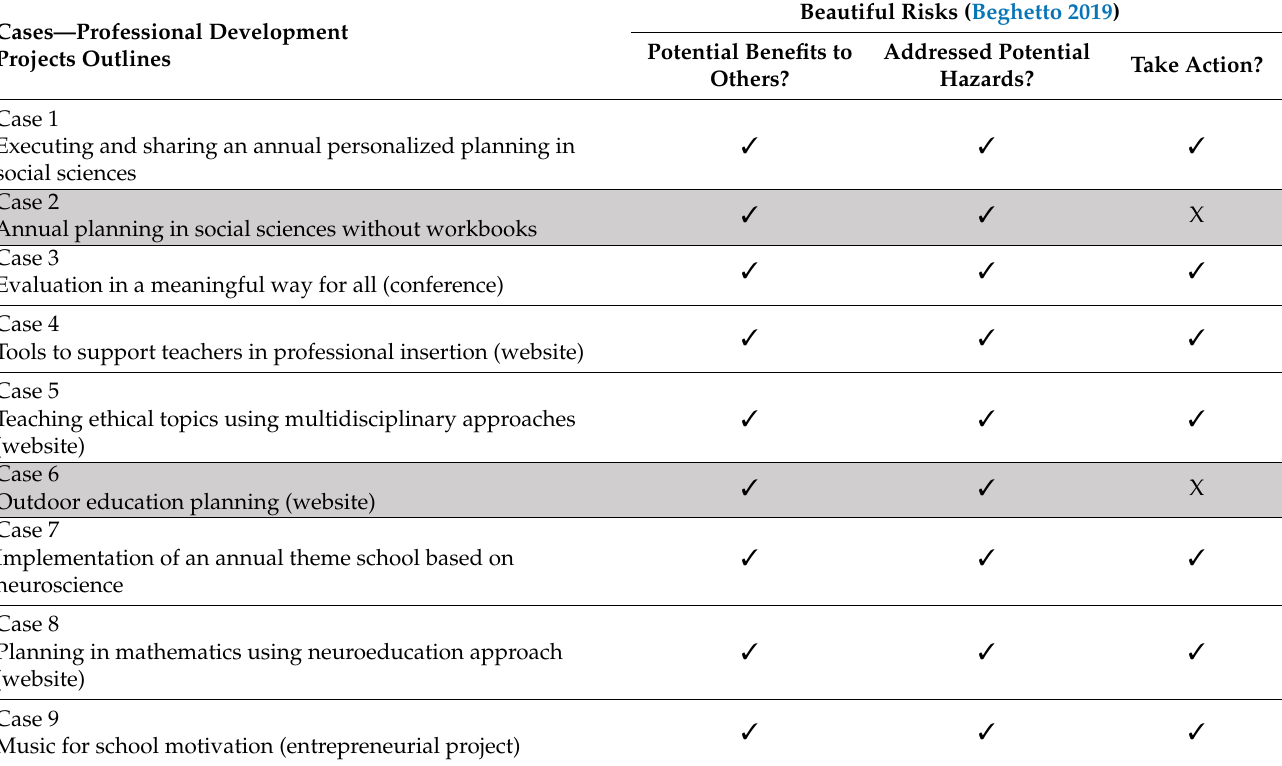
Table 1. Professional Development Project: Beautiful